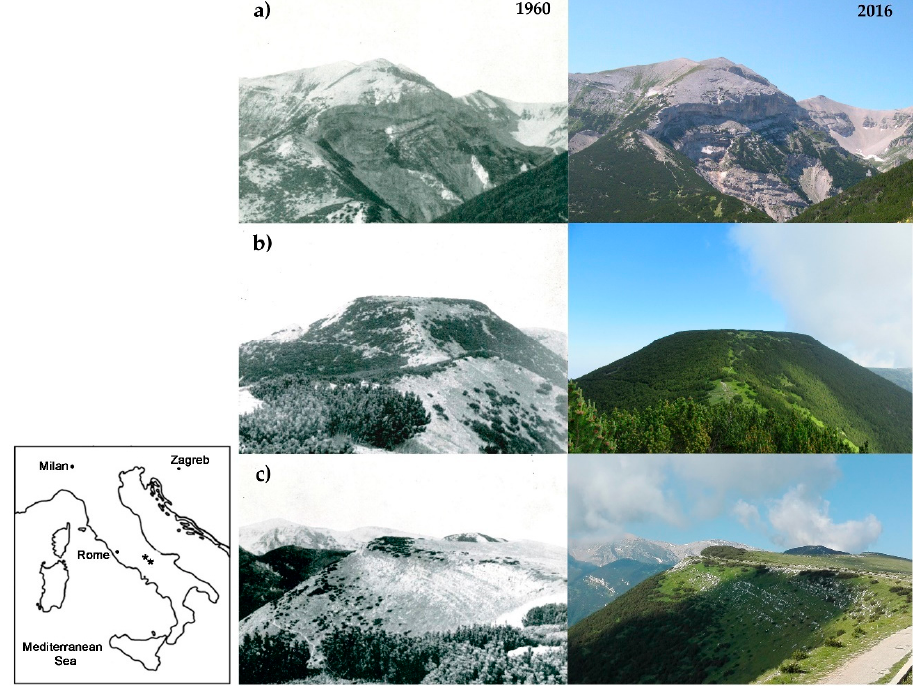
Figure 1. Locations of the study areas in Central Italy along with a photographic comparison of Pinus mugo formations in the years 1960 [57] and 2016 in three localities of the Majella massif: ( a ) Mt. Cavallo and Mt. Focalone, ( b ) Blockhaus, and ( c ) Maielletta. The main changes in the landscape are related to an increase in krummholz density across the treeline ecotone.